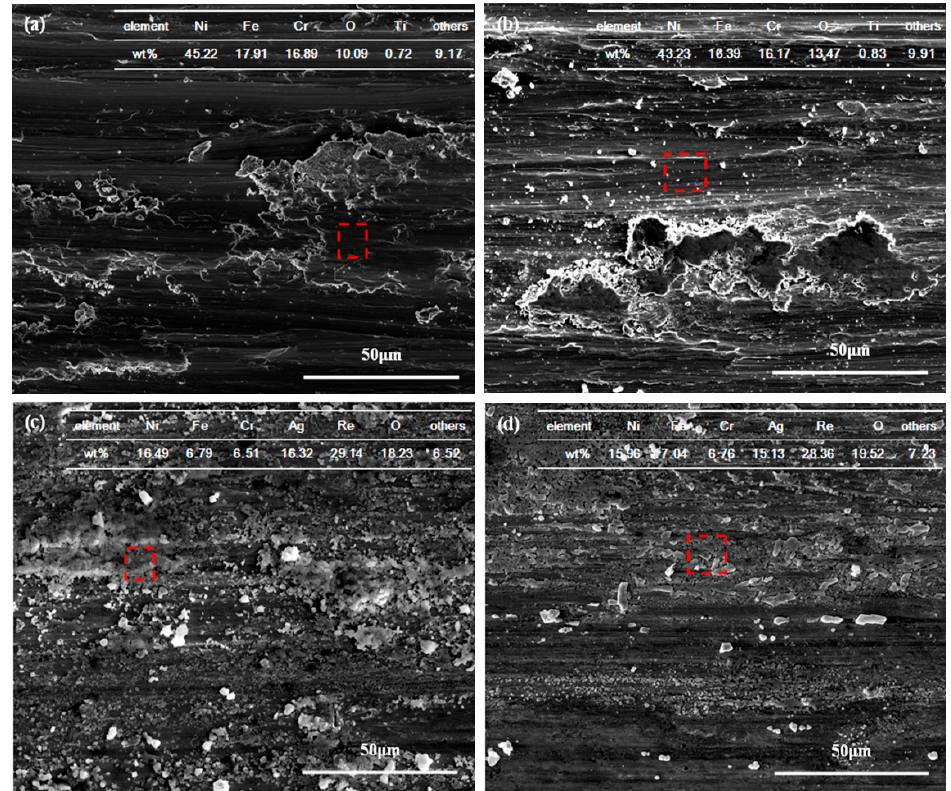
Figure 9. The SEM micrographs of worn surface of GH4169 alloy after 10 min sliding tests lubricated by various lubricating samples at elevated temperatures. ( a ) 300 °C, PAO; ( b ) 400 °C, PAO; ( c ) 300 °C, PAO + SA + 0.5 wt% AgReO 4 ; ( d ) 400 °C, PAO + SA + 0.5 wt% AgReO 4 .